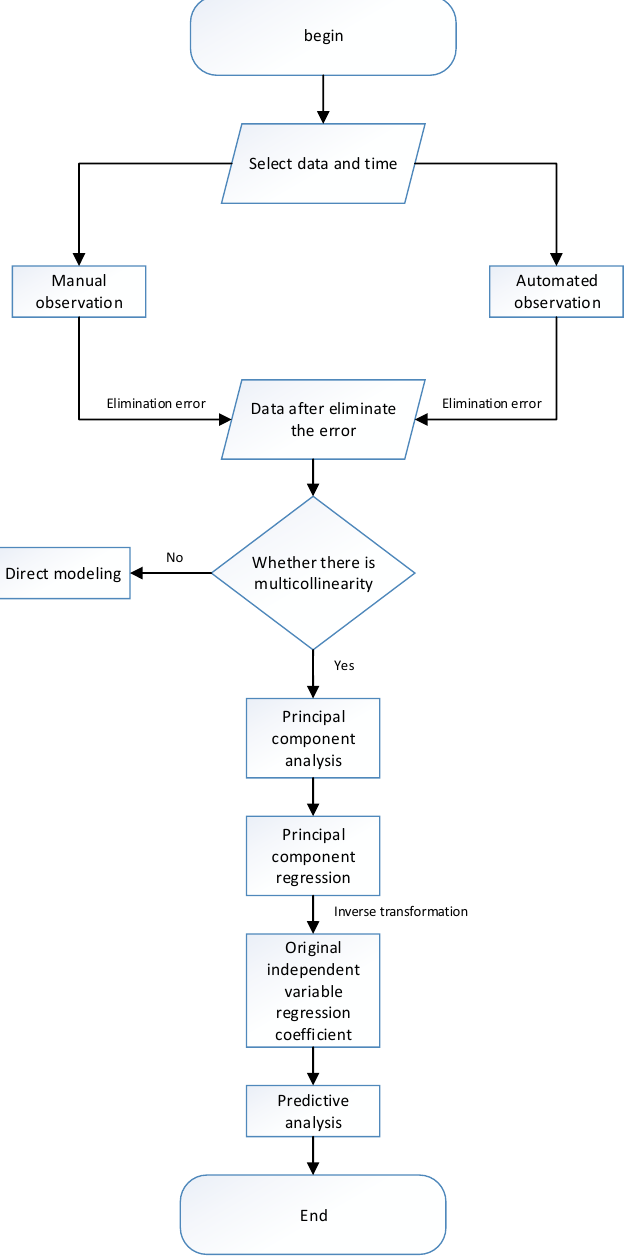
Figure 5. The flow chart of research work.